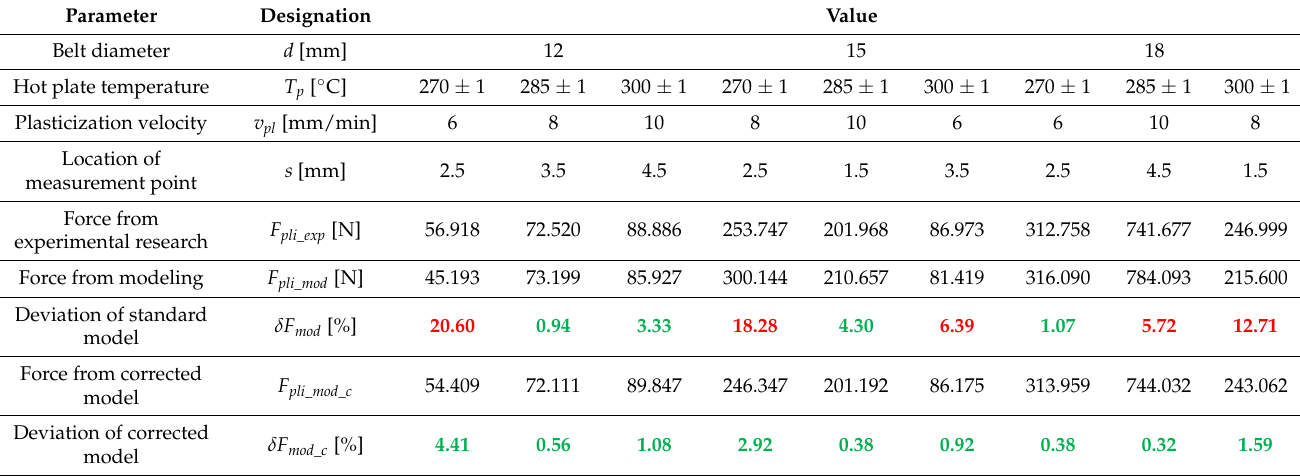
Table 2. The results of the comparison between the initial modeled plasticization force F pl_mod and experimental results F pl_exp , and corrected model of plasticization force F pl_mod_c for a few control points s i